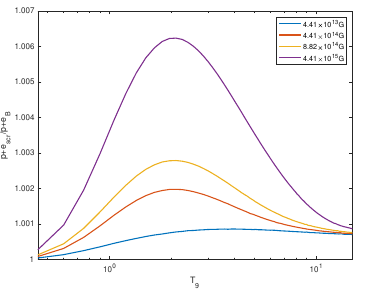
Figure 1. The screening correction to the pe − → n ν reaction rate as function of T 9 under di ff erent PMF strength. Y-axis is the ratio between the reaction rate with screening correction and without the